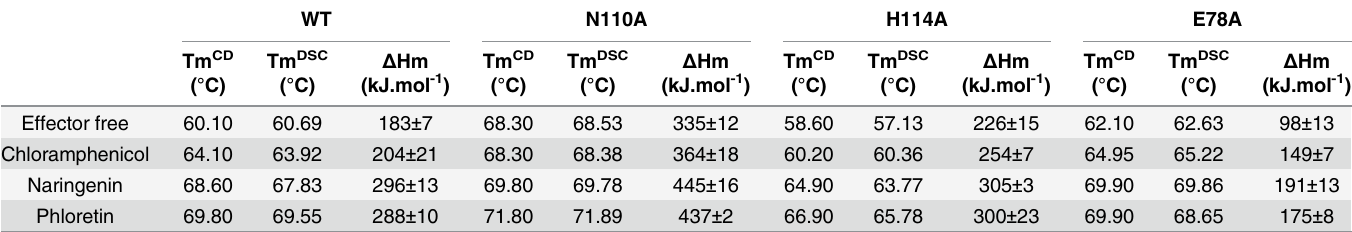
Table 2. Thermodynamic parameters obtained by DSC and CD. Thermodynamic parameters for the thermal unfolding of TtgR WT and variants (TtgR H114A , TtgR N110A , TtgR E78A and TtgR S77A ) obtained from DSC and far-UV CD measurements. Internal calibrations of the CD and DSC equipments give errors in Tm of ± 0.20°C and ± 0.10°C respectively.